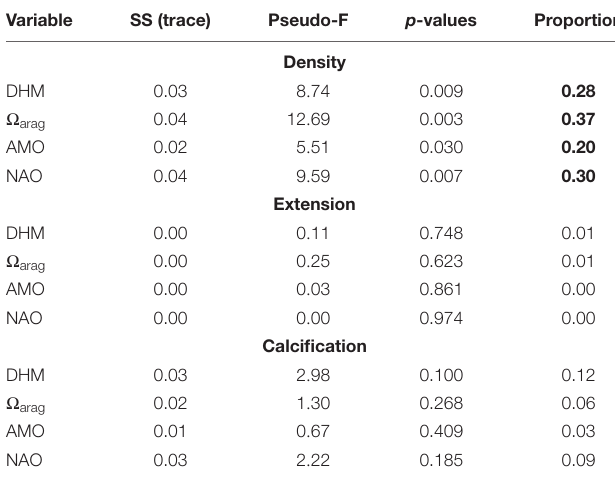
TABLE 4 | Results of the marginal test for the period 1988–2011 performed by DISTLM forward